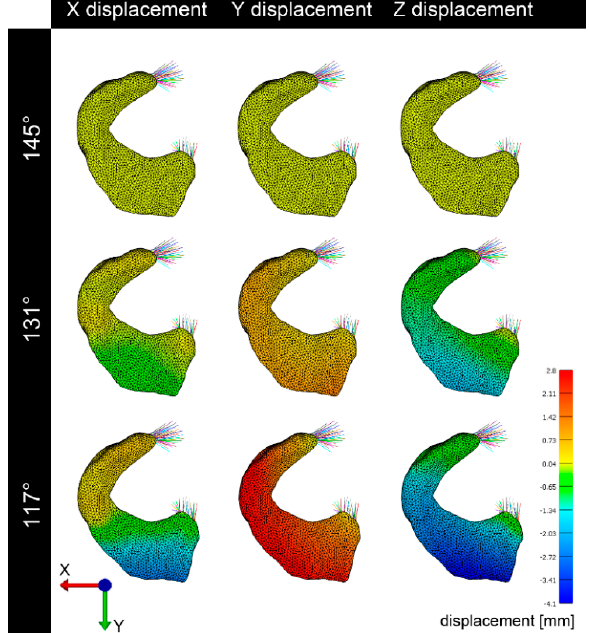
Figure 4. Translocation/deformation of the lateral meniscus. In the X-axis, the lateral meniscus shows some deformation. While the cranial horn shows little displacement, the caudal horn moves medially. Strong translocation of the lateral meniscus occurs in the Y-axis, showing that at high flexion (117°) the meniscus moves caudally. A remarkable translocation occurs also in the vertical (Z) axis, showing that at high flexion (117°) the meniscus is pushed distally.